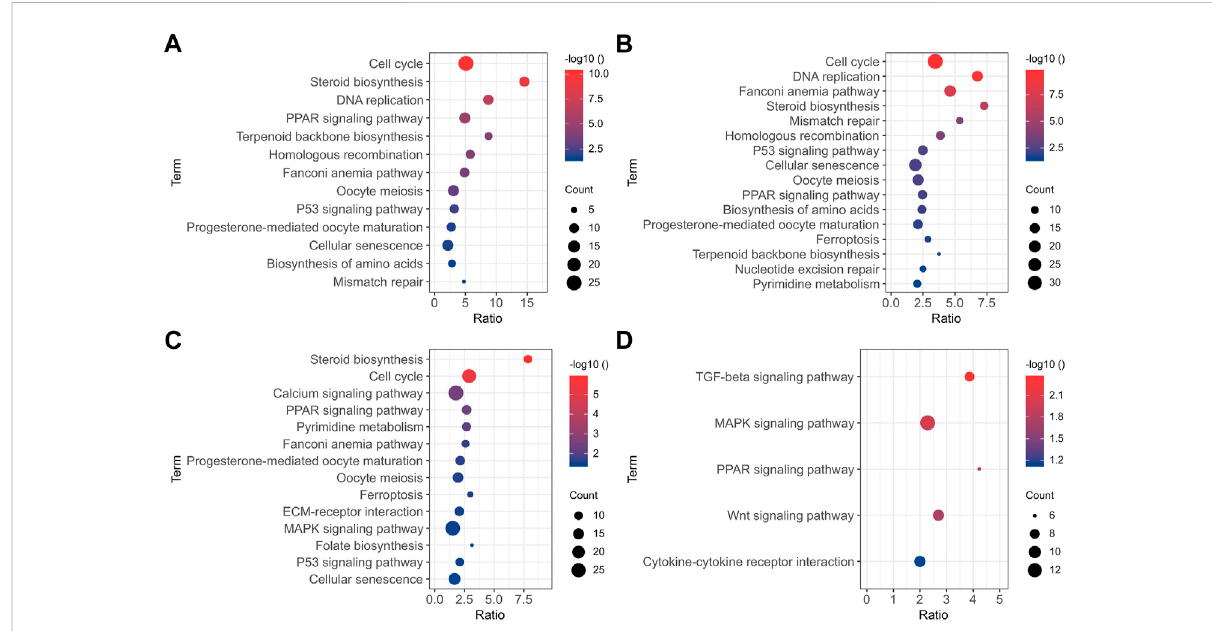
FIGURE 3 KEGG pathway analysis ( p < 0.05) of DEGs between 0 and -1 (A) , 1 and 0 (B) , 11 and 1 (C) , and 22 and 11 (D) d of osteogenic